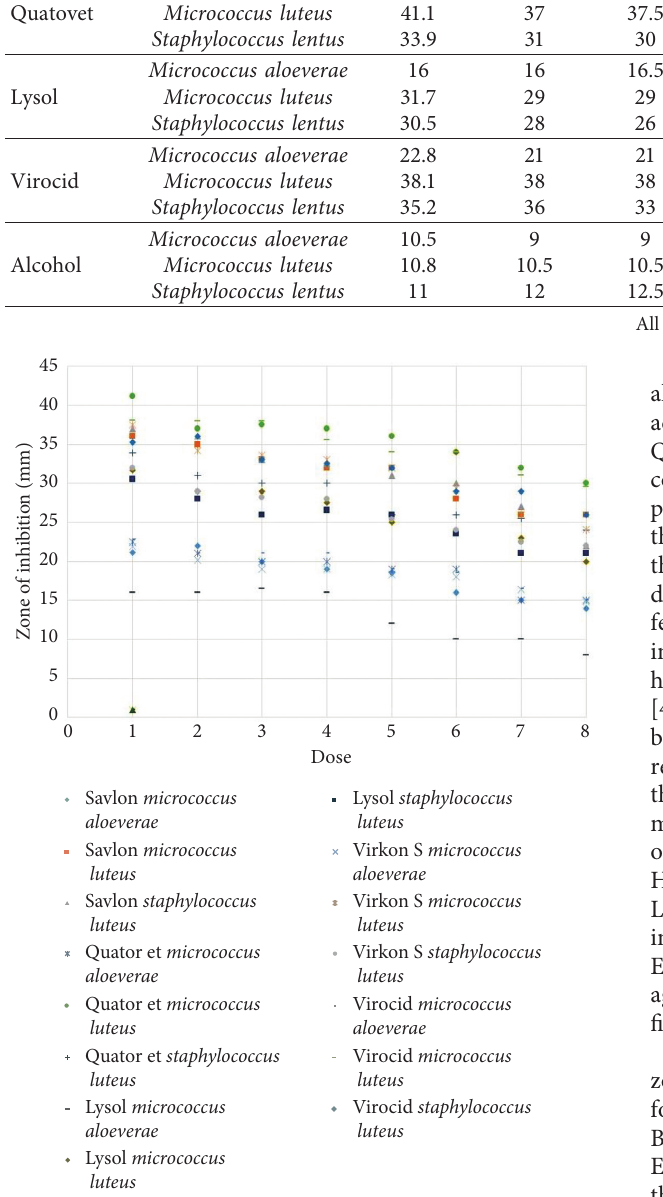
Figure 5: Inhibition zone diameters of selected isolates of mi- crococci/staphylococci organisms against the disinfectants tested at different concentrations varying from 100% to 30% dose con- centrations. X axis represents the concentrations and Y axis rep- resents the diameters of inhibition zones in millimeter